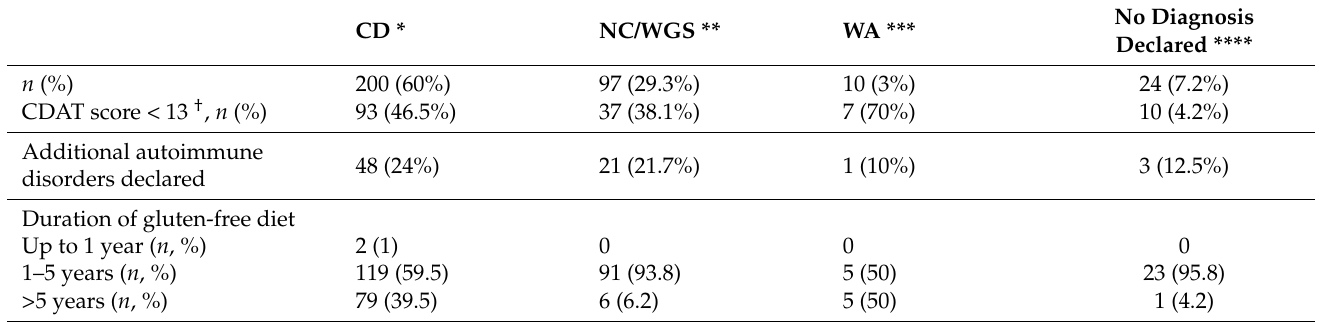
Table 2. CDAT score, non-celiac autoimmune diseases declared, and years on GFD by declared